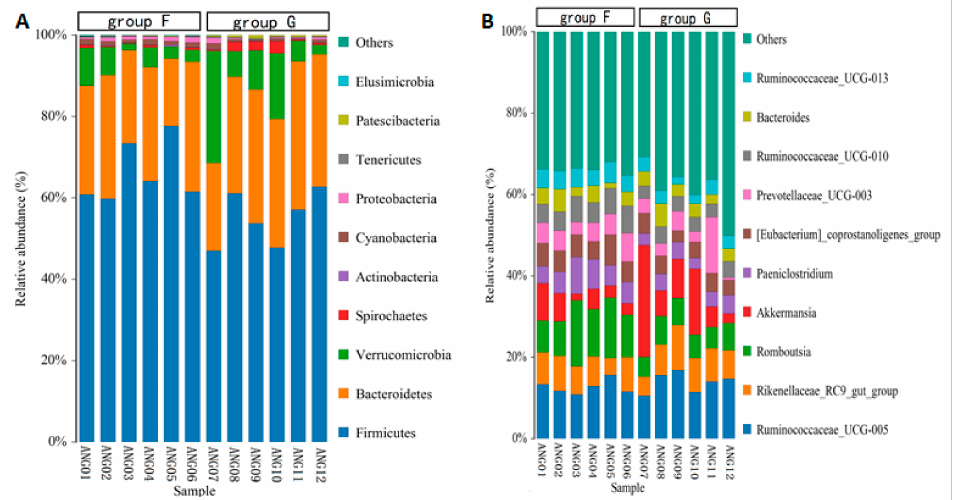
Figure 4. Relative abundance of fecal microbiota at the phylum level ( A ) and at the genus level ( B